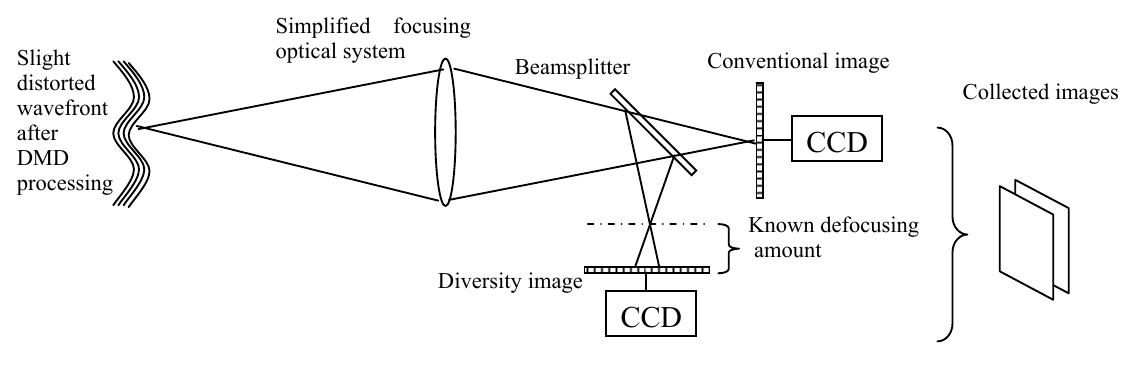
Figure 3. Data-collection scheme for phase diverse speckle